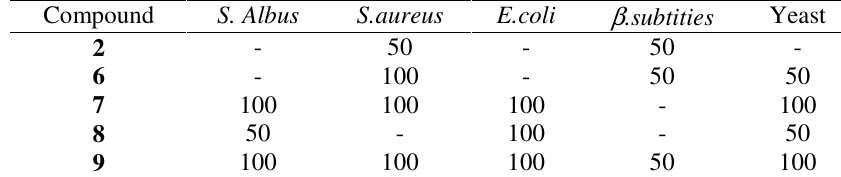
Table 2 . In vitro biological activity of the compounds ( 2, 6, 7, 8, 9 )